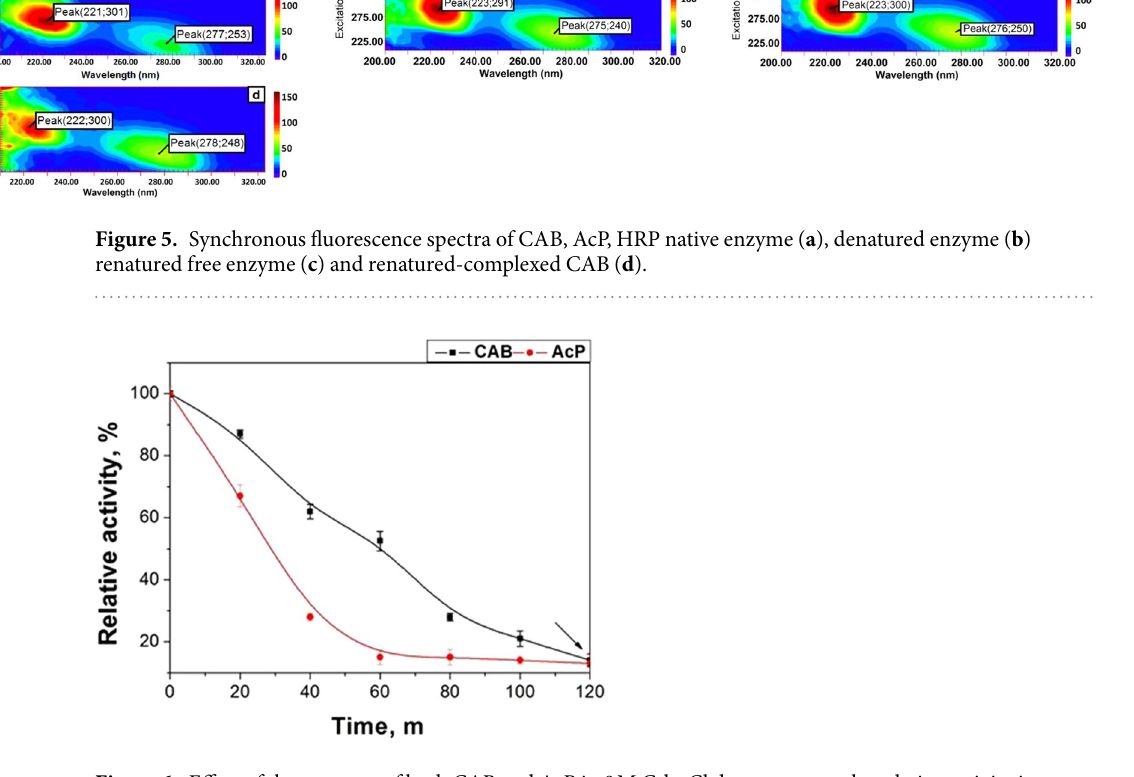
Figure 6. Effect of the presence of both CAB and AcP in 8 M GdmCl denaturant on the relative activity in